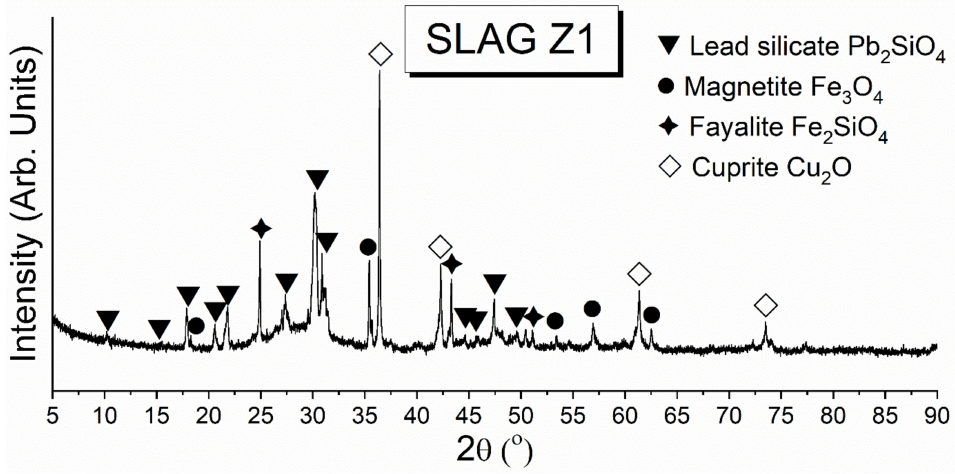
Figure 2. XRD pattern of the test slag [42].